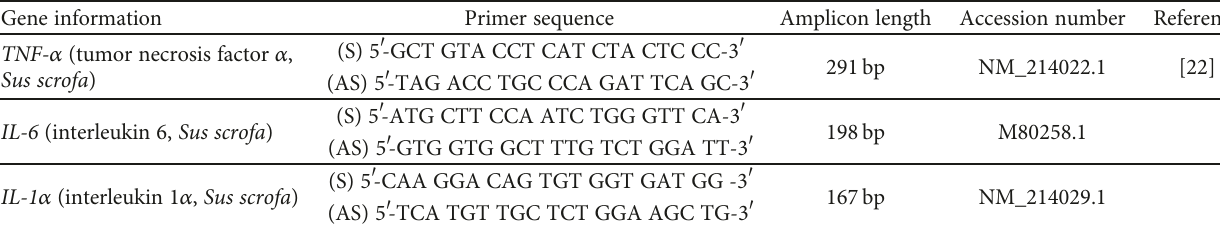
Table 1: Oligonucleotide primers and amplicon length of PCR products.